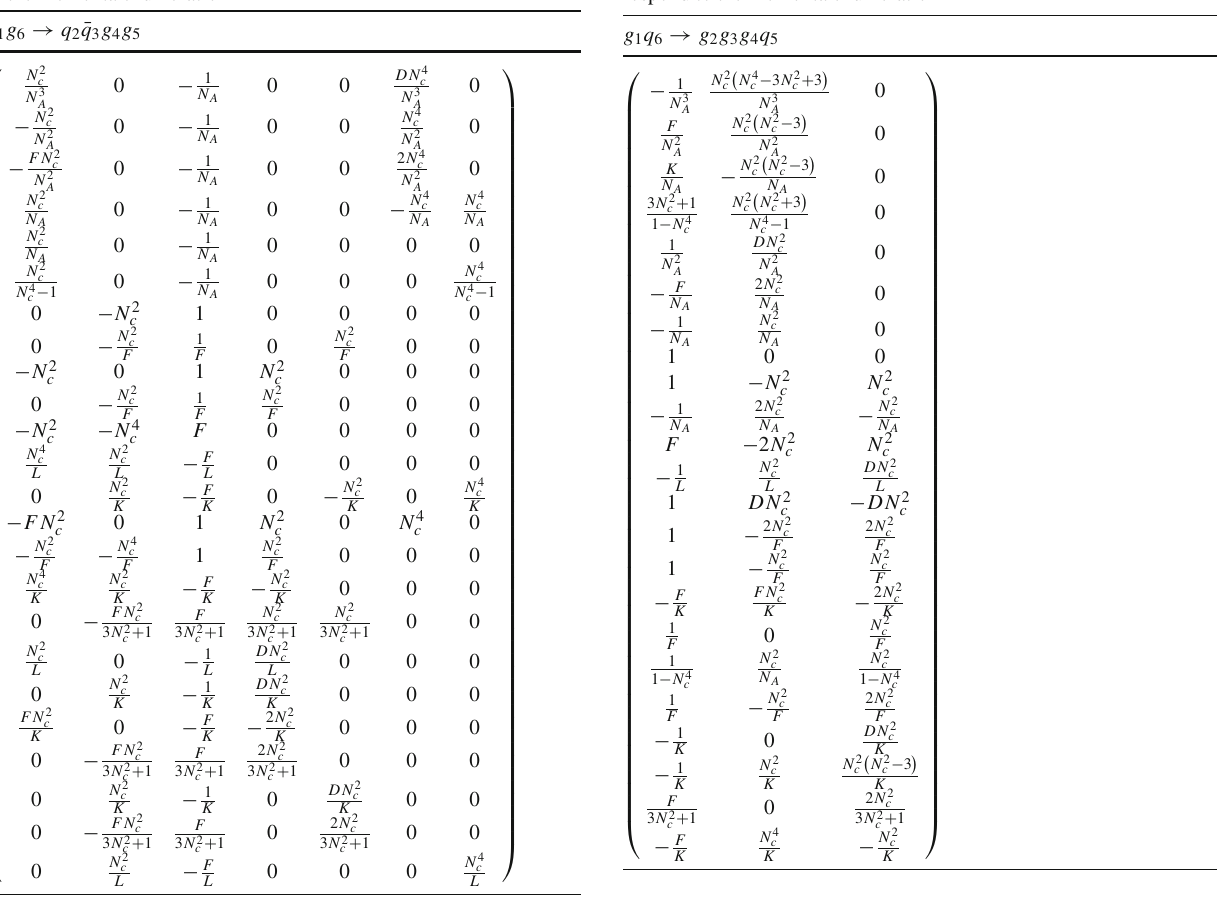
Table 9 Matrices M of structures appearing in the six-parton processes (part II) ( D = N 2 c − 2, F = N 2 c + 1, K = N 4 c − 2 N 2 c − 1, L = N 4 c − N 2 c − 1). The subscripts in the sub-process indication correspond to the momenta enumeration